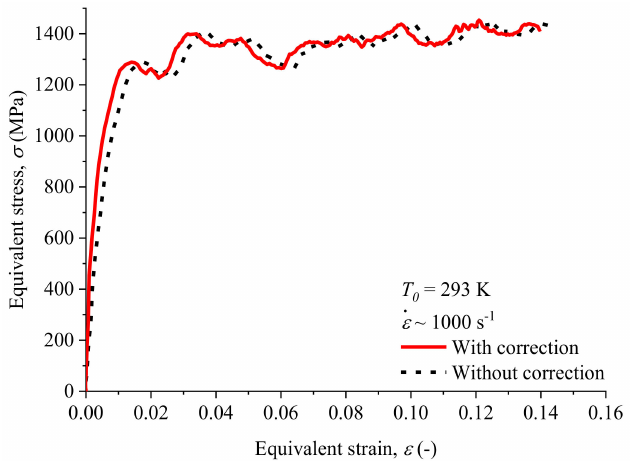
Figure 1. Comparison of the results obtained with and without the punching correction in dynamic compression.